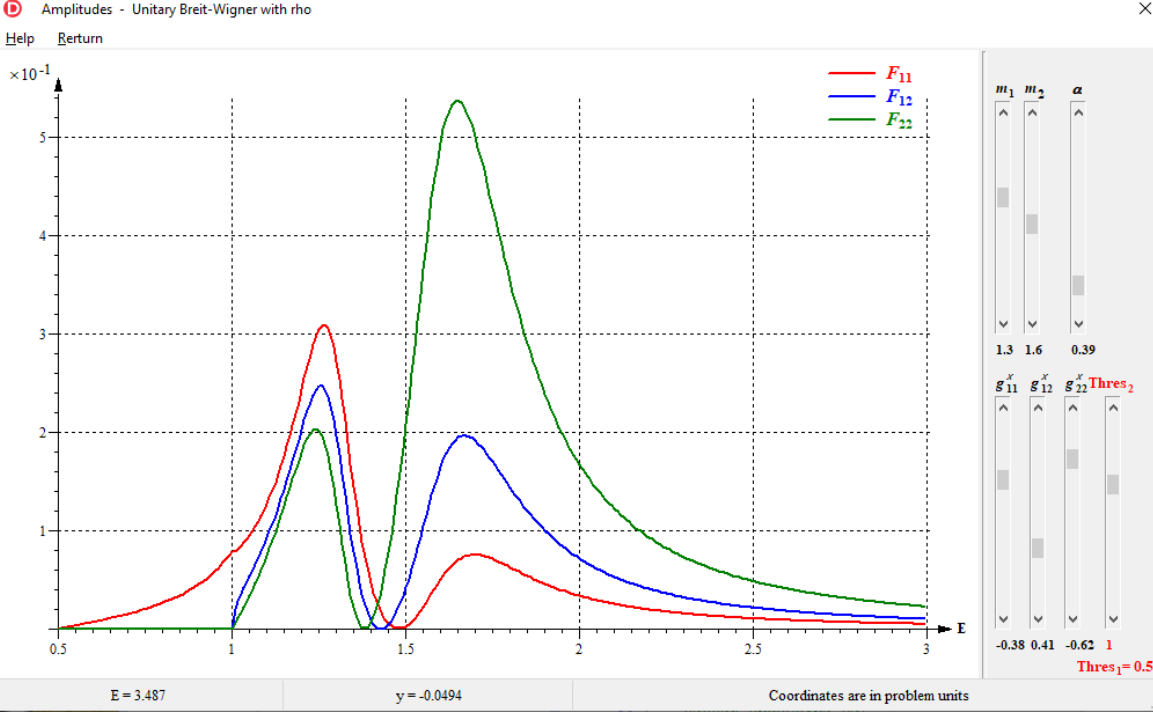
Figure A5. Unitary BW scattering amplitudes.